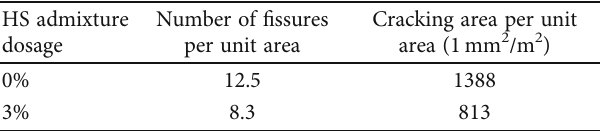
Figure 3. The benchmark specimen (0%) had a high capillary